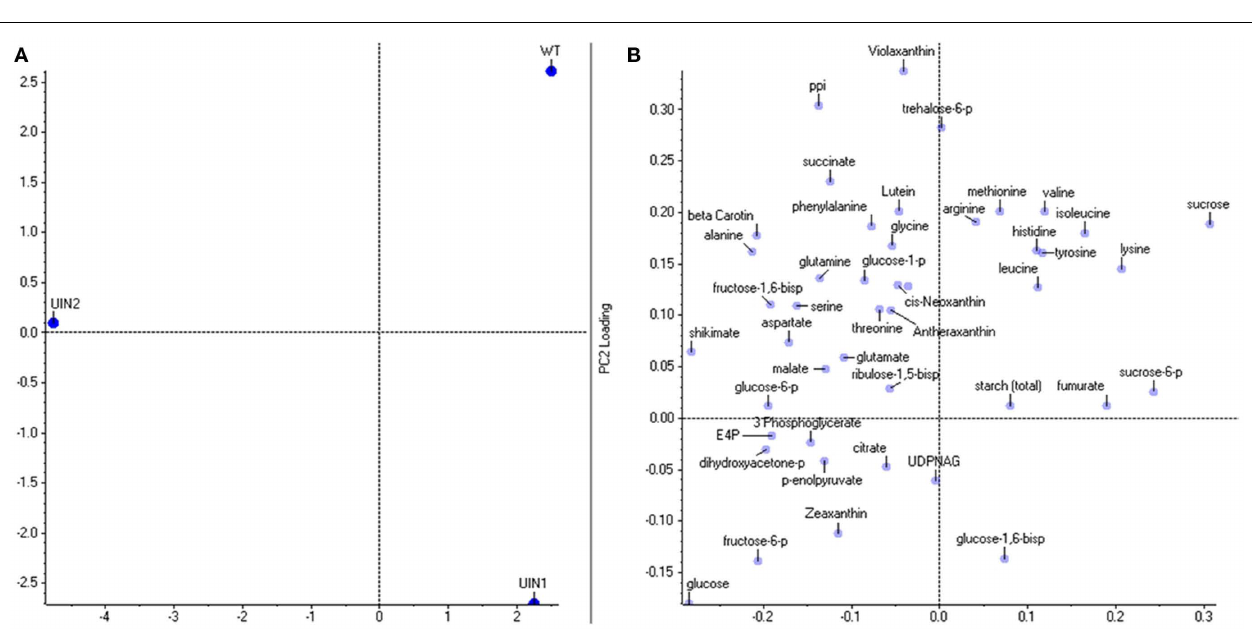
FIGURE 2 | Relative enrichment of functional groups in differentially expressed transcripts of U-IN-1 (black) and U-IN-2 (gray). Enrichment is